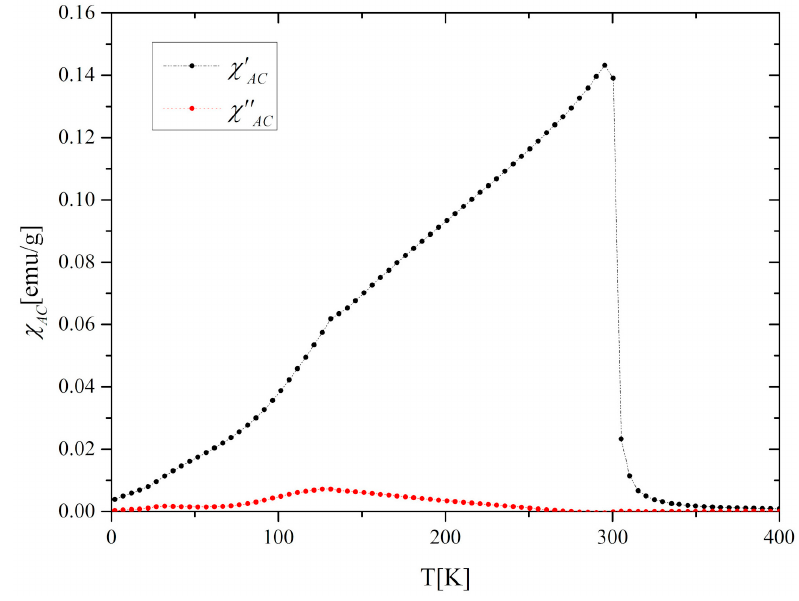
Figure 3. The AC magnetic susceptibility ( χ AC ) of the Gd 0.4 Tb 0.6 Co 2